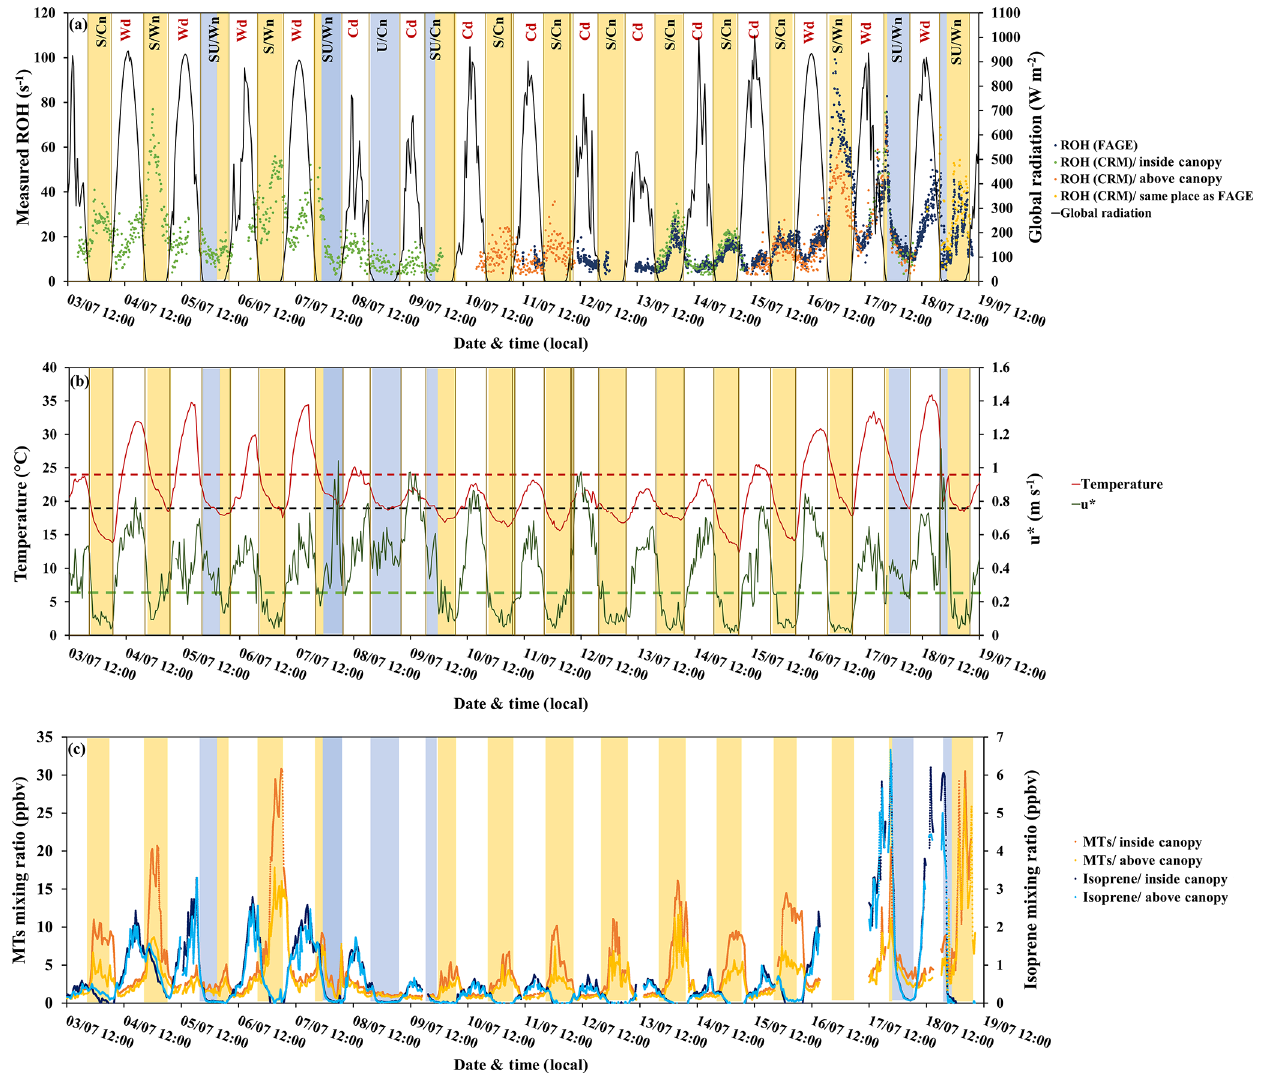
Figure 5. Variability of measured OH reactivity by LSCE-CRM and UL-FAGE inside and above the canopy with (a) global radiation (black), (b) temperature (red), friction velocity (green), and (c) monoterpene and isoprene concentrations. Yellow stripes indicate stable nighttime atmospheric conditions (S nights with mean u ∗ ≤ 0 . 2ms − 1 ), and blue stripes indicate unstable nighttime conditions (U nights with mean u ∗ ≥ 0 . 4ms − 1 ). Class SU includes nights with stable and unstable atmospheric conditions (blue + yellow stripes). Wn and Wd stand for warm nights and warm days, respectively. Cn and Cd stand for cooler nights and cooler days, respectively. Red dashes and black dashes indicate the temperature thresholds to distinguish warm and cool days and nights, respectively. Green dashes indicate the friction velocity threshold to distinguish stable and unstable